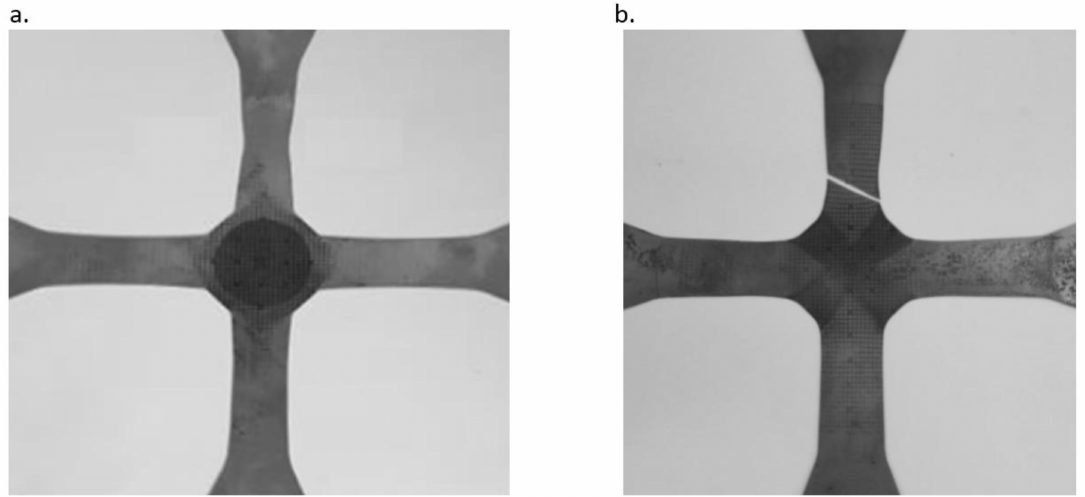
Figure 18. Pictures of samples after the biaxial tensile tests: ( a ) Specimen_1, ( b )